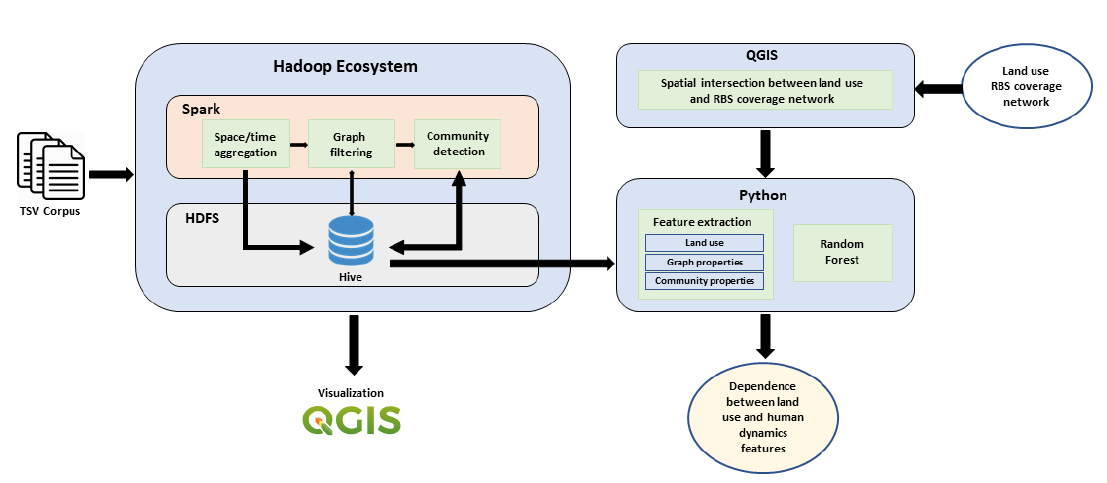
Figure 6. System